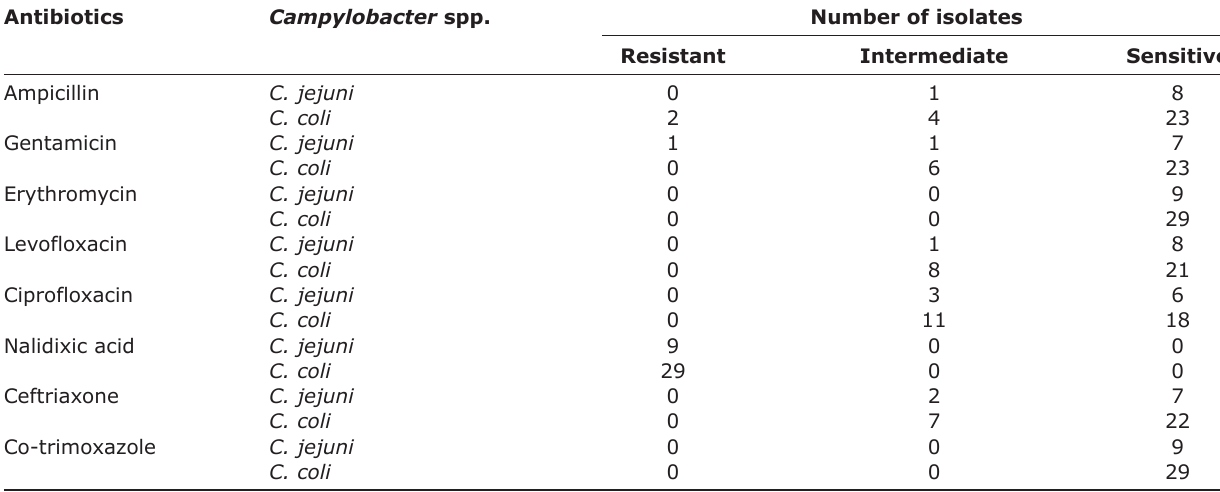
Table-5: Antibiotic sensitivity pattern among Campylobacter isolates.